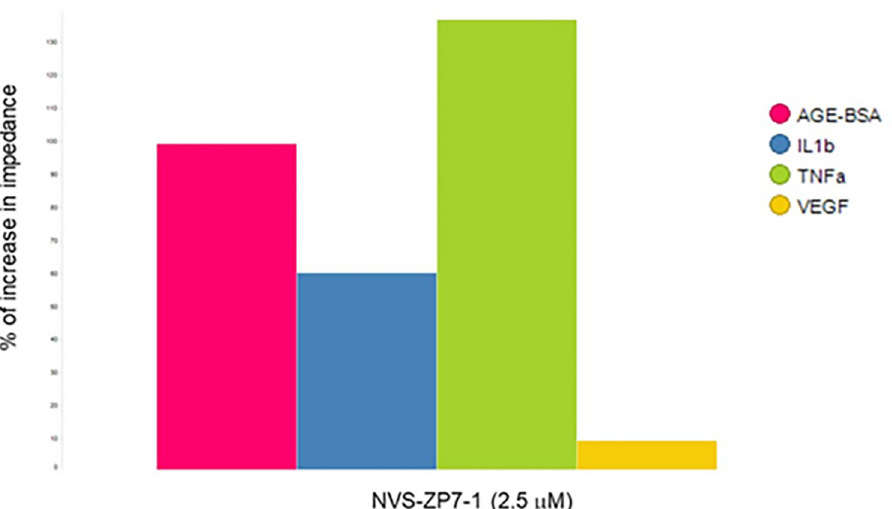
Fig 6. Zip7 inhibition prevents impedance loss in primary human retinal endothelial cells induced by IL-1 β , TNF- α α and glycated BSA. Impedance was measured in confluent primary human retinal endothelial cells overnight in media, media + IL-1 β (5 ng//mL), media + (TNF- α 5 ng/mL), media + AGE-BSA (250 μ g/mL) and media + VEGF (50 ng/mL) in the presence and absence of NVS-ZP7-1. The % increase in impedance when compound was present versus challenge alone was calculated at 24h. Zip7 inhibition reduced impedance loss caused by IL-1 β , TNF- α and glycated BSA but not by VEGF.